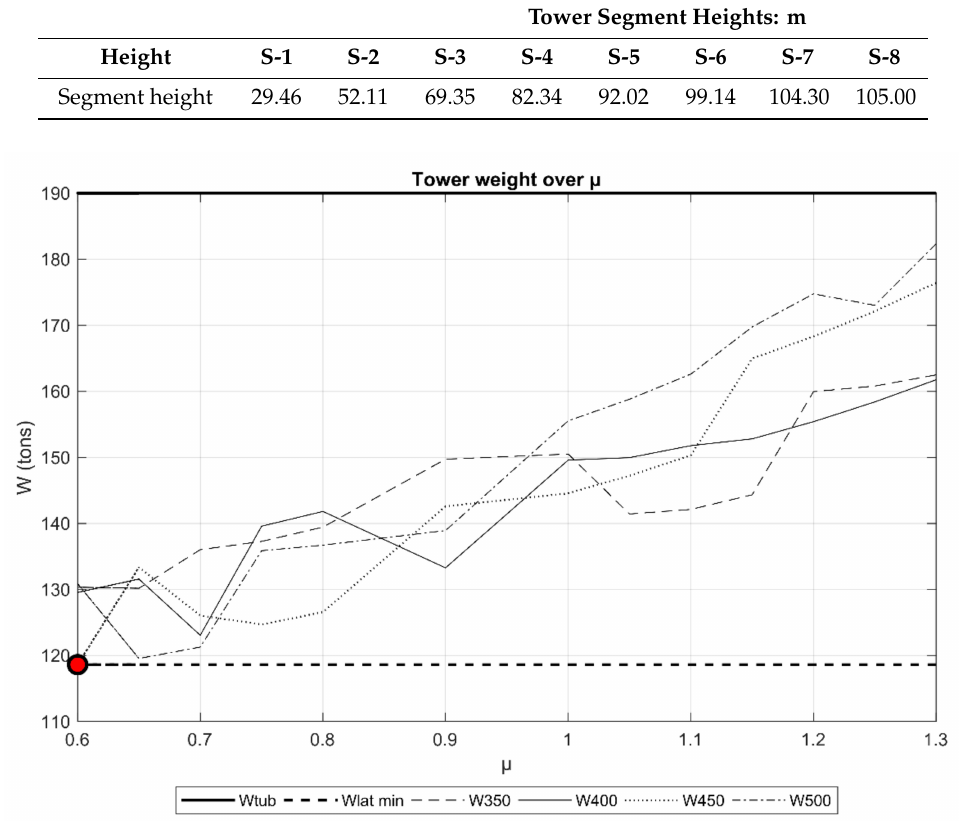
Figure 15. Total weight of tower cases in correlation with µ and Btop for the 105 m towers.